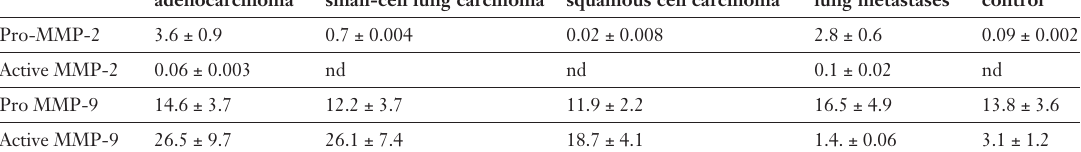
Representative gelatine zymography for six characteristic bronchial washings obtained from patients with extrapul- monary primary tumours.